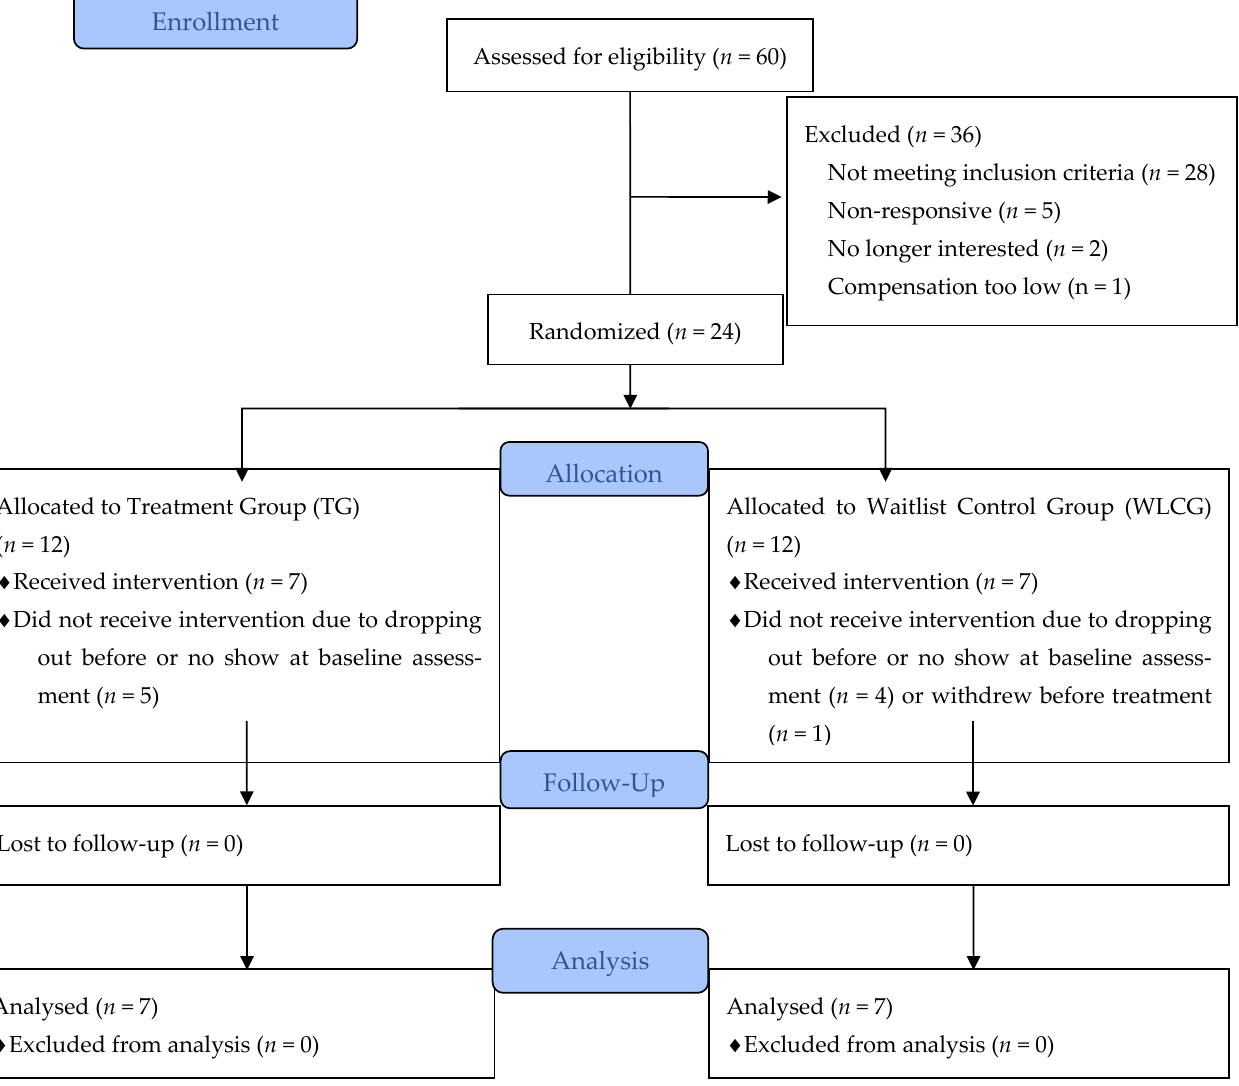
Figure 2. CONSORT diagram of female-identifying undergraduate participants and eligibility status for five-week intuitive eating intervention.